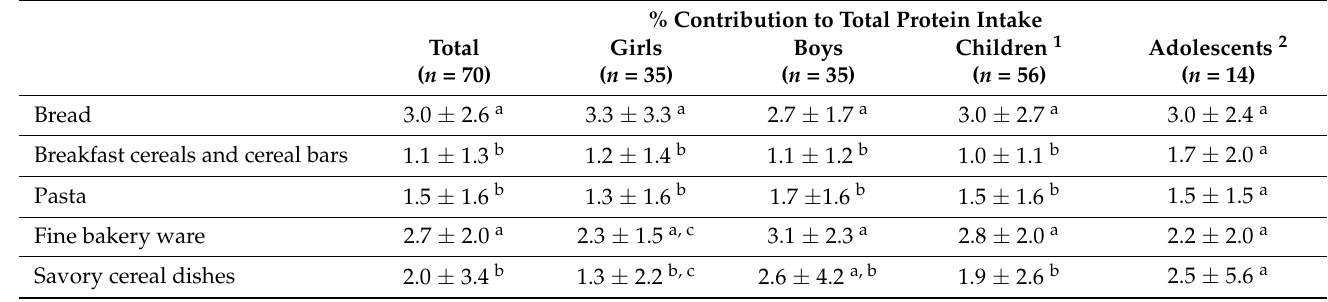
Table 7. Contribution of the different types of gluten-free products of to the daily protein intake in Spanish children and adolescents, both genders, with celiac disease.